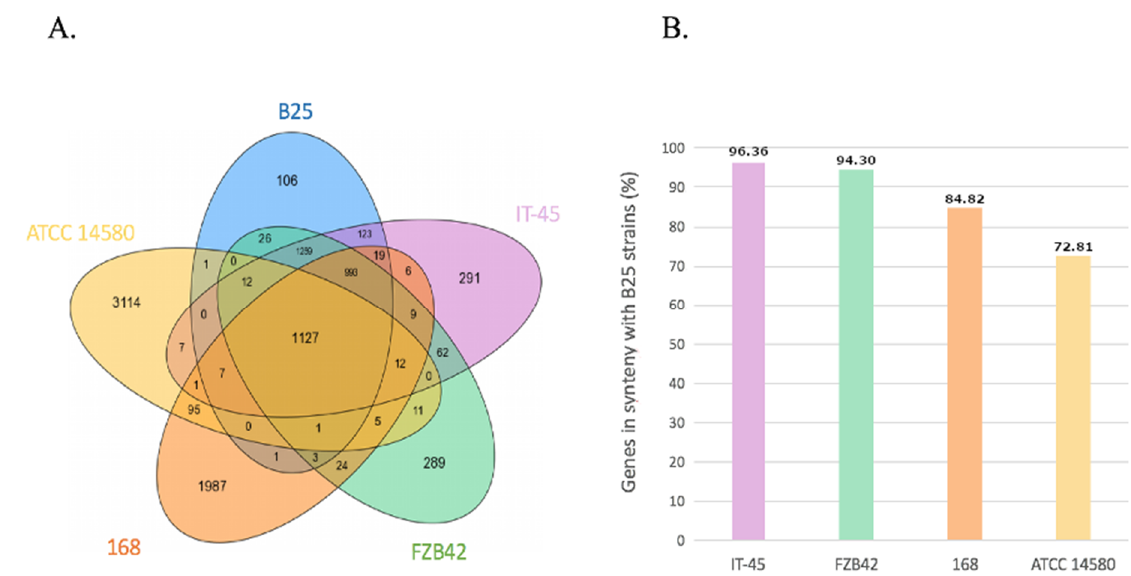
Figure 1. Comparisons of Bacillus velezensis strain B25 genome with four other Bacillus spp. ( B. methylotrophicus FZB42, B. amyloliquefaciens IT-45, B. subtilis 168 et B. licheniformis ATCC 14580). ( A ) Venn diagram of genome-specific or common genes between B25 and the other strains. ( B ) Percentage of genes in conserved synteny between B25 and the other strains.